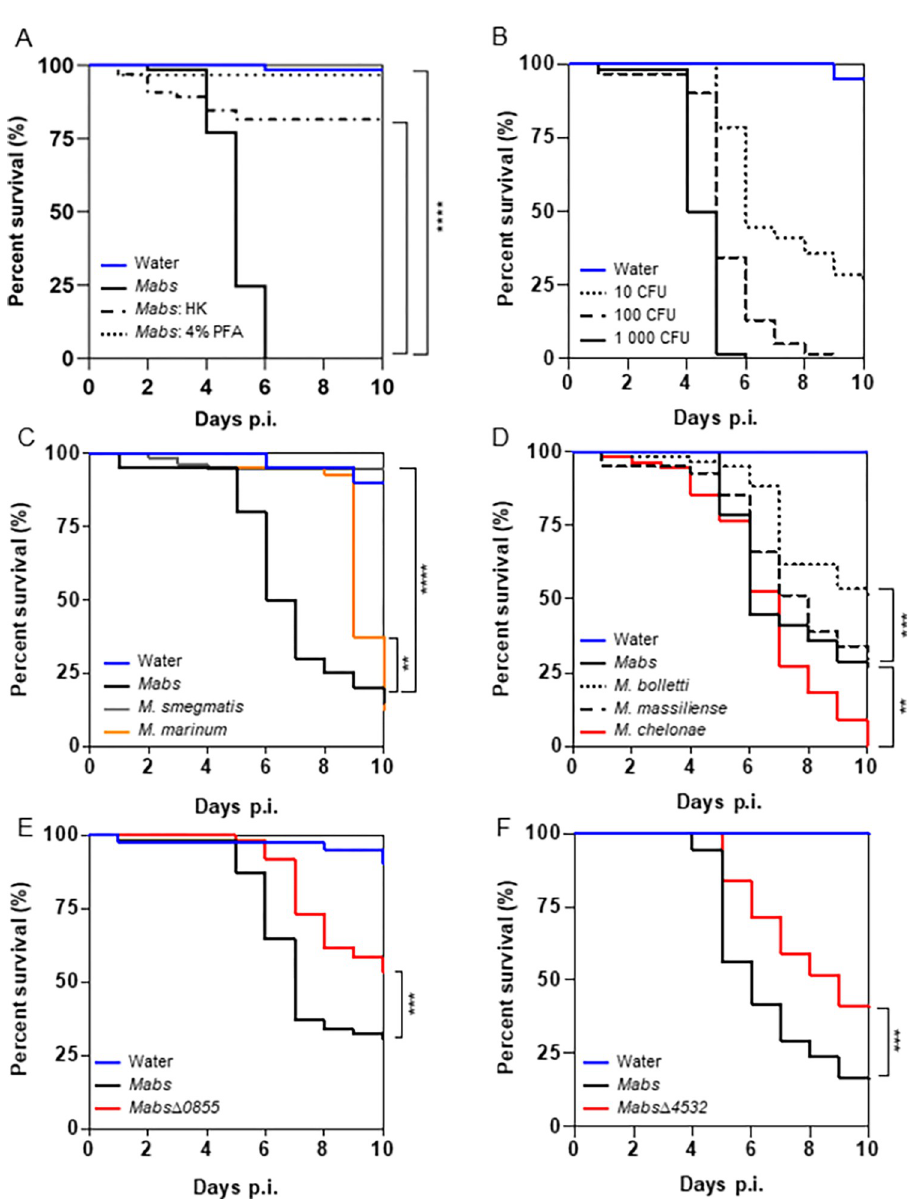
Fig 1. M . abscessus is virulent in Drosophila . (A-F) (A) Survival curves of w 1118 flies injected with water or 1,000 CFU (Colony Forming Unit) of living M . abscessus ( Mabs ), heat-killed M . abscessus ( Mabs : HK) or M . abscessus fixed with 4% PFA ( Mabs : 4% PFA) (B) different doses of live M . abscessus (10, 100 or 1,000 CFU) (C) 10 CFU of different mycobacterial species of different virulence ( M . abscessus , M . marinum or M . smegmatis ) (D) 10 CFU of different subspecies of M . abscessus and M . chelonae (E-F) 10 CFU of M . abscessus and the M . abscessus Δ 0855 mutant strain (E) and Δ 4532 mutant strain (F), both defective for intracellular growth. The curves represent the survival of 60 flies. The data were analyzed using the log-rank statistical test. Asterisks represent p values ** p < 0.01, *** p < 0.001, **** p < 0.0001. damage and to prevent reactive oxygen species (ROS) production by macrophages [30]. Injec- tion of each of these mutants caused a lower mortality as compared to wild-type M . abscessus infection (Fig 1E and 1F). We also infected flies with three M . massiliense 43S mutants strains, known to have a transposon (Tn) insertion in a gene of the ESX-4 locus and to be impaired in